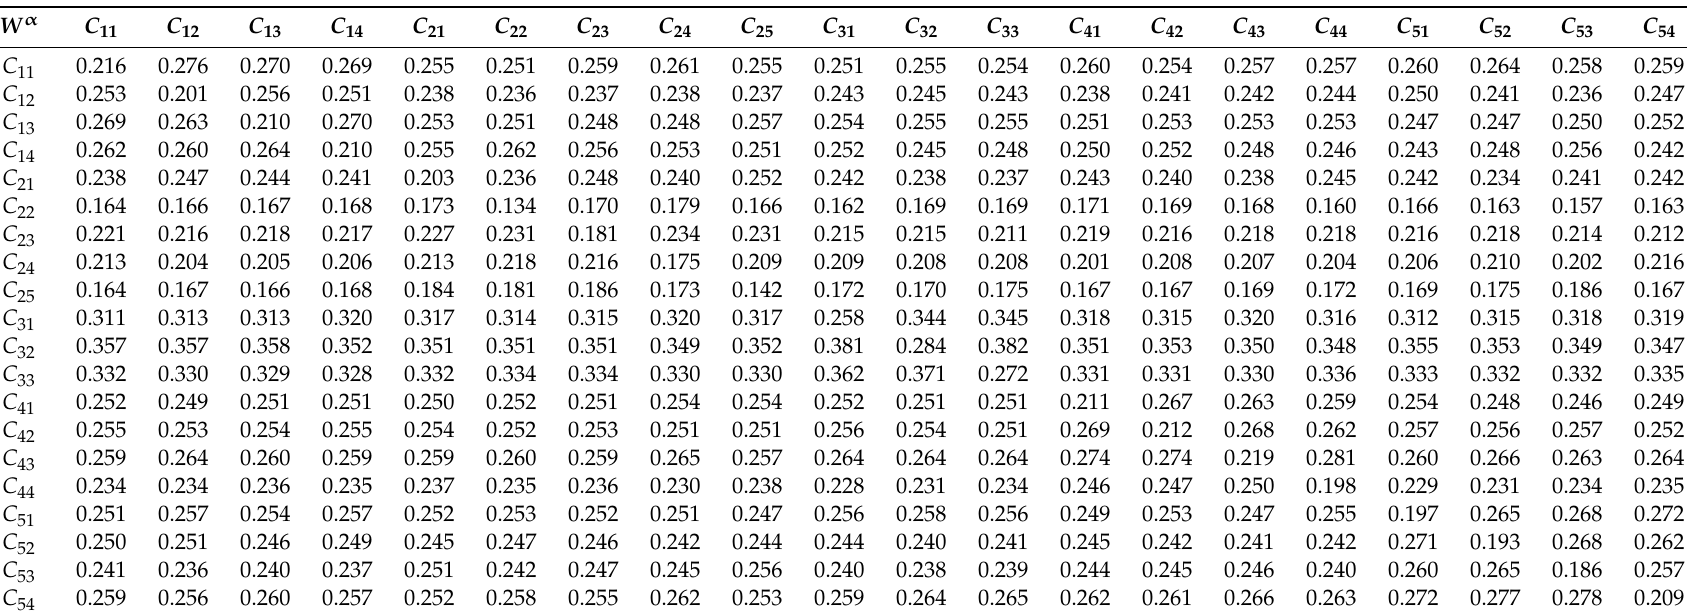
Table A6. The un-weighted supermatrix of criteria W α